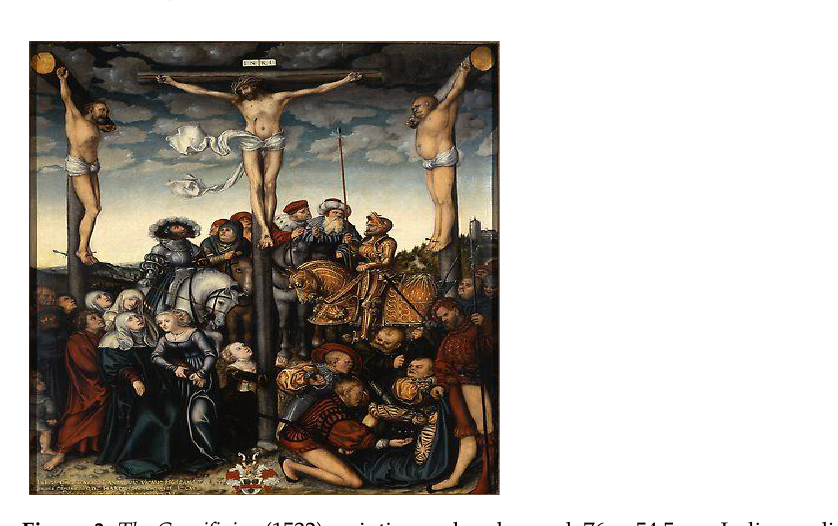
Figure 3. The Crucifixion (1532), painting on beech wood, 76 × 54.5 cm, Indianapolis Museum of Art, The Clowes Collection: https://lucascranach.org/en/US_IMA_2000-344 , accessed on 27 February 2023).